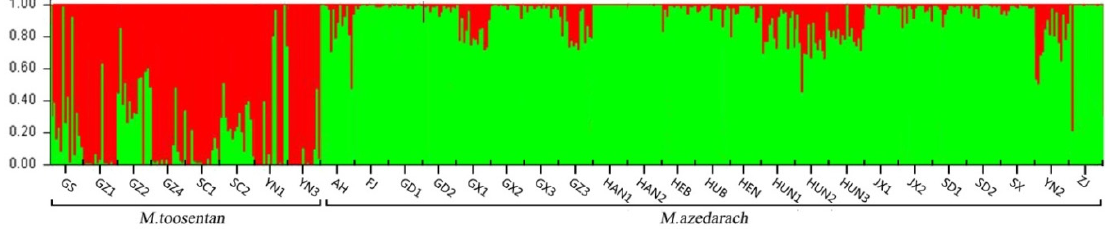
Figure 3. Clustering analysis of 31 Melia populations with STRUCTURE.